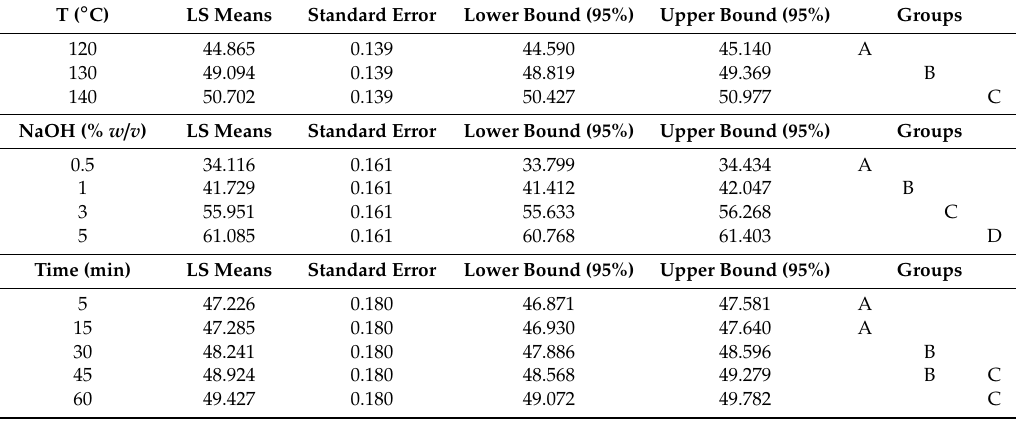
Table 2. Tukey’s HSD test results for the MW-A + sulfolane-TiO 2 pretreatment in relation to the TRS yield (%). Analysis of the di ff erences between the categories with a confidence interval of 95% for: temperature (top), NaOH concentration (center) and time